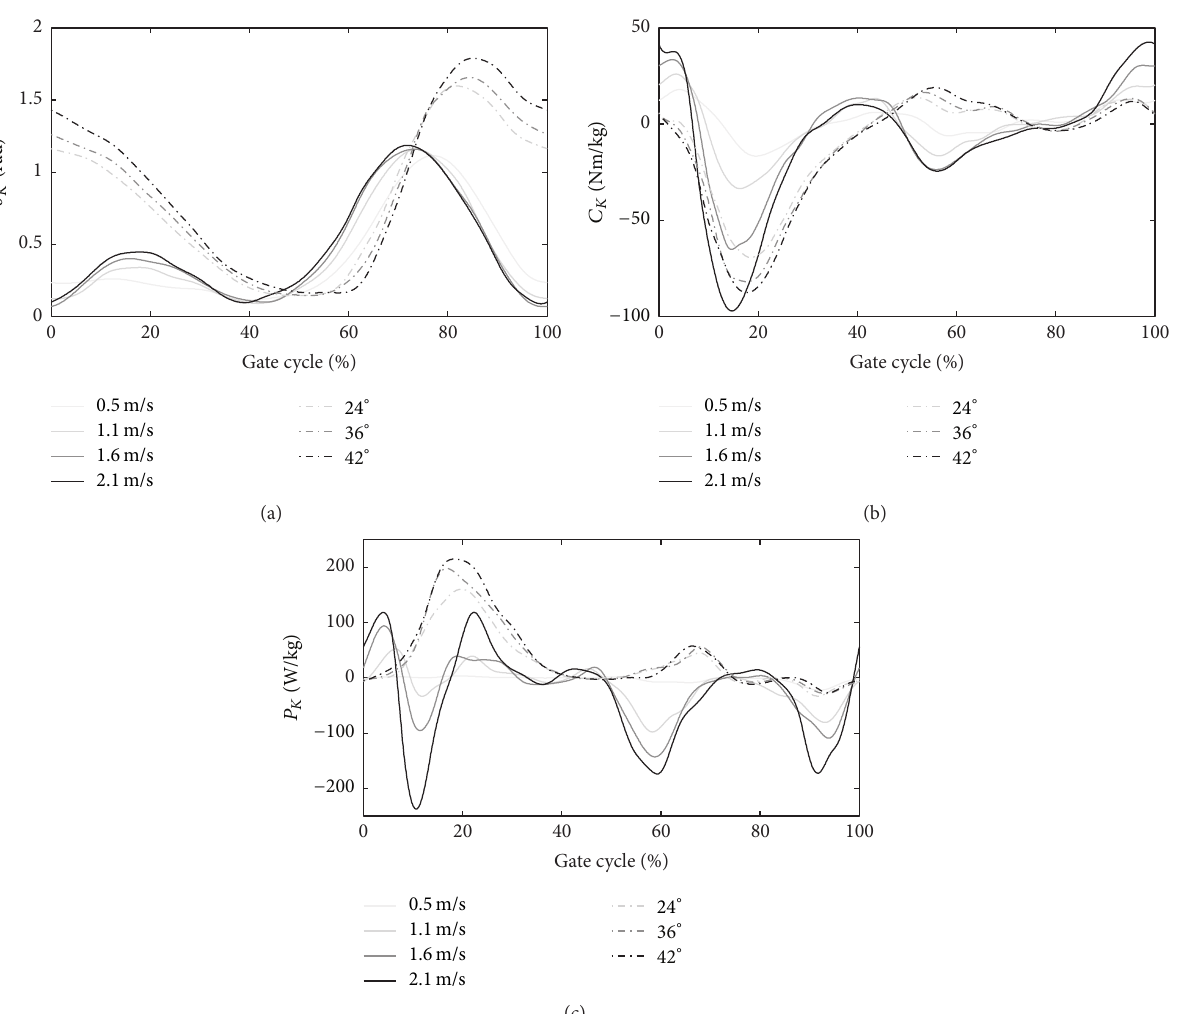
Figure 1: Gait cycle analysis data of the knee joint (angle, torque, and power) in level ground walking at different speeds and in stairs climbing at different inclinations. Data were adapted from [17, 18].